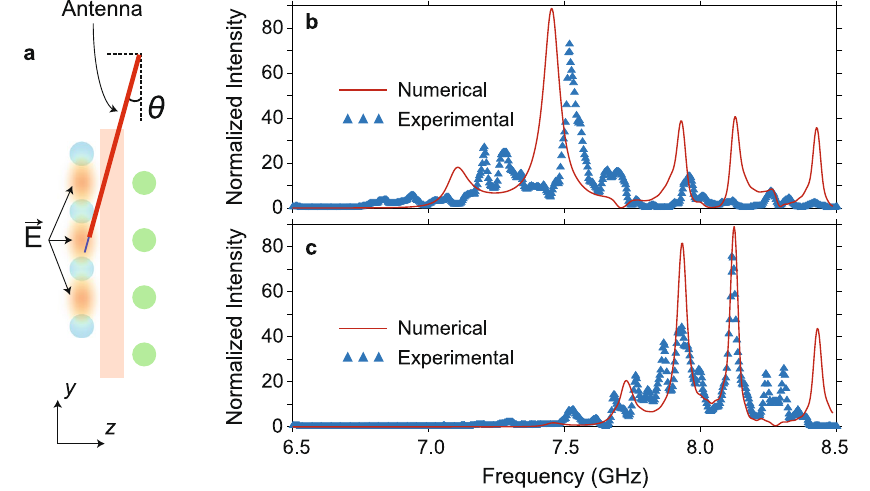
Figure 8. Field enhancement measurements. ( a ) Schematic description of the measurement of the electric field intensity inside the structure. The numerically calculated and experimentally measured electric field intensity spectra, obtained at the center of the xy - plane and at a distance equal to ( b ) 9.25 cm and ( c ) 17.15 cm in the z - direction with respect to the input of the structure are